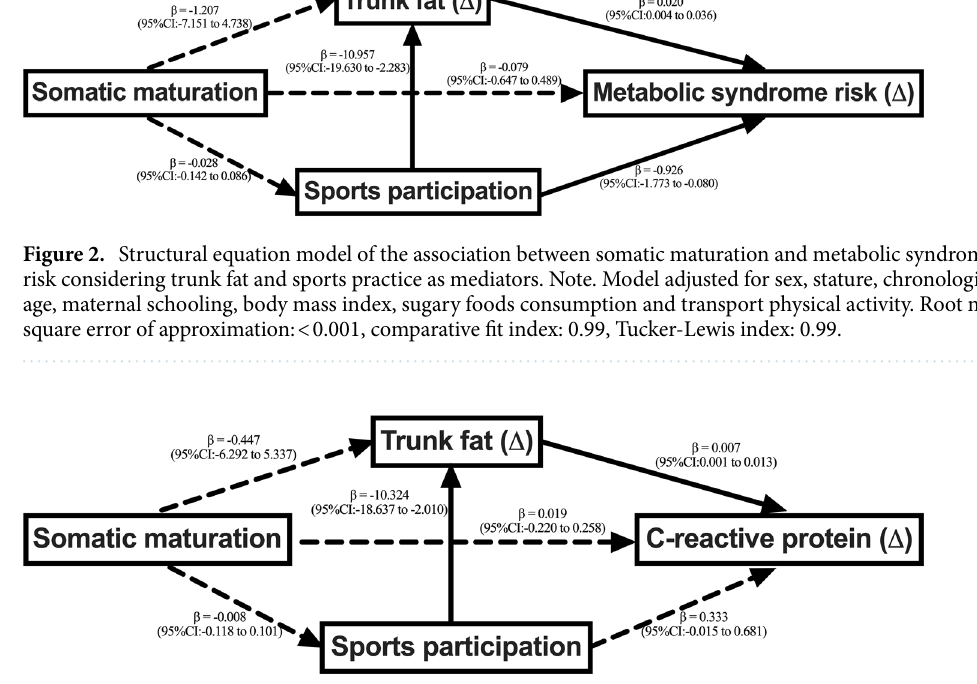
Figure 3. Structural equation model of the association between somatic maturation and c-reactive protein considering trunk fat and sports practice as mediators. Note. Model adjusted for sex, stature, chronological age, maternal schooling, body mass index, sugary foods consumption and transport physical activity. Root mean square error of approximation: < 0.001, comparative fit index: 0.99, Tucker-Lewis index: